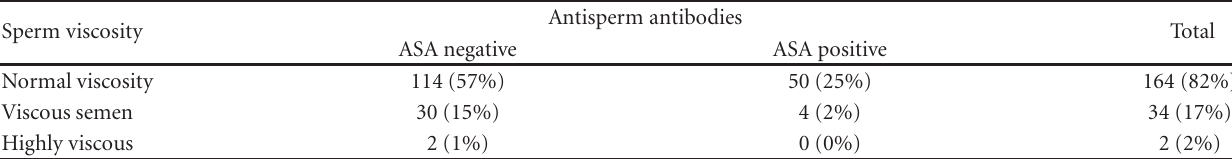
Table 2: Relationship between autoantisperm antibodies and sperm